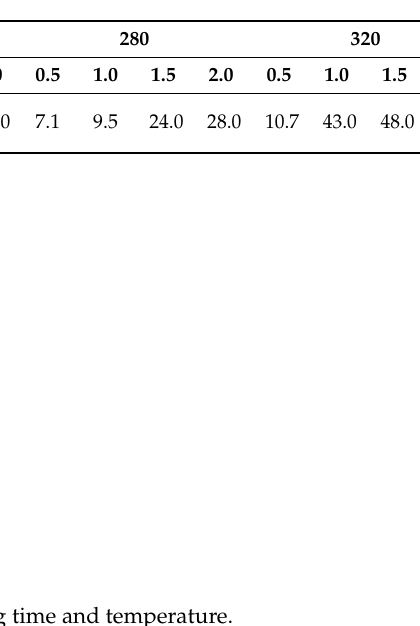
Figure 10. Diffusion layer thickness with annealing time and temperature.